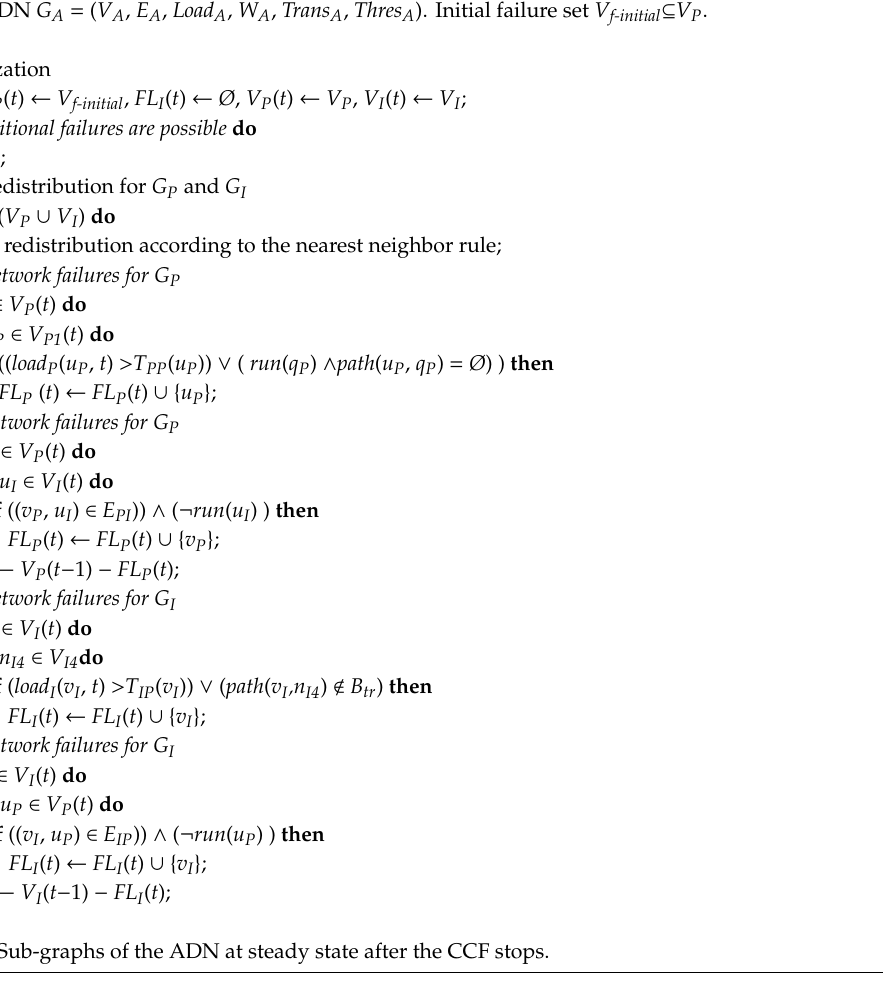
Algorithm 1 Stead-state Subgraph Generating Algorithm (taking nodes failures of the PN as an example)